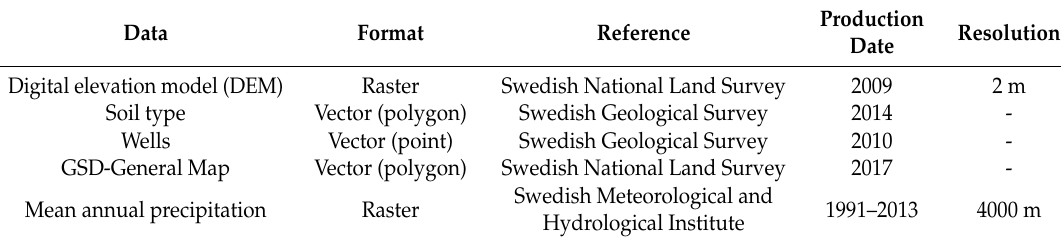
Table 1. Data used in this